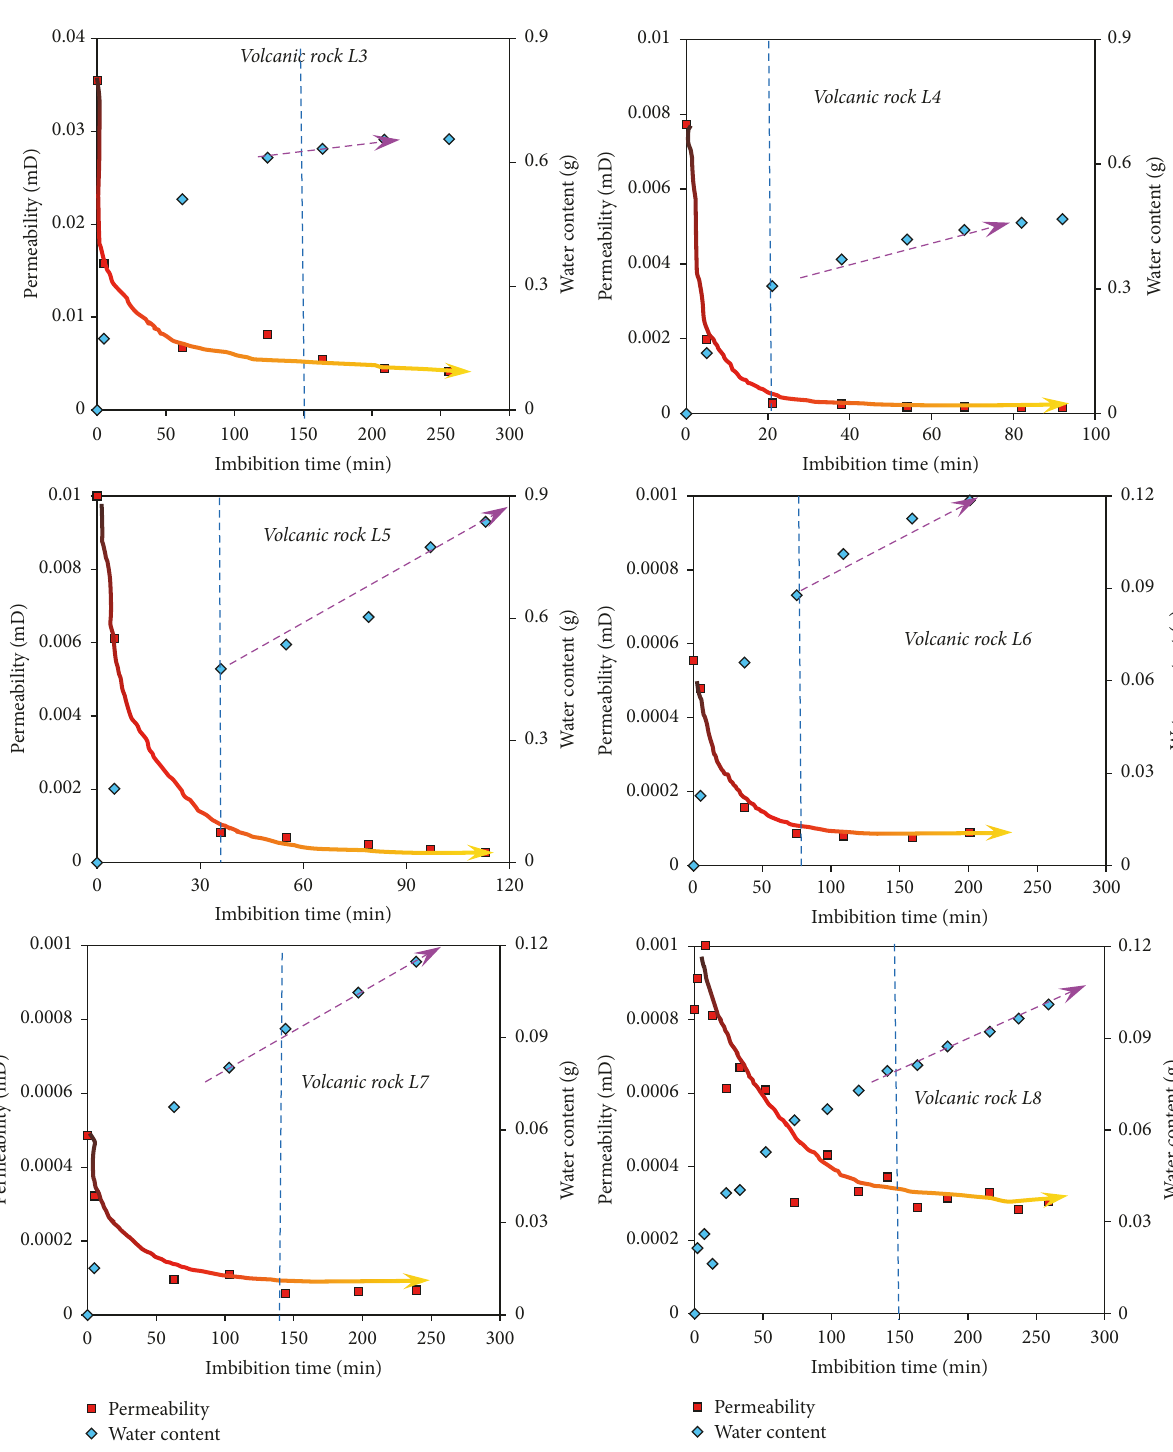
Figure 6: Permeability and water content as a function of imbibition time: volcanic rocks L3–L8. The rocks imbibition occurred with only one surface contacting the distilled liquid. The permeability refers to the pulse-decay permeability. The red trend line represents the direction of the permeability